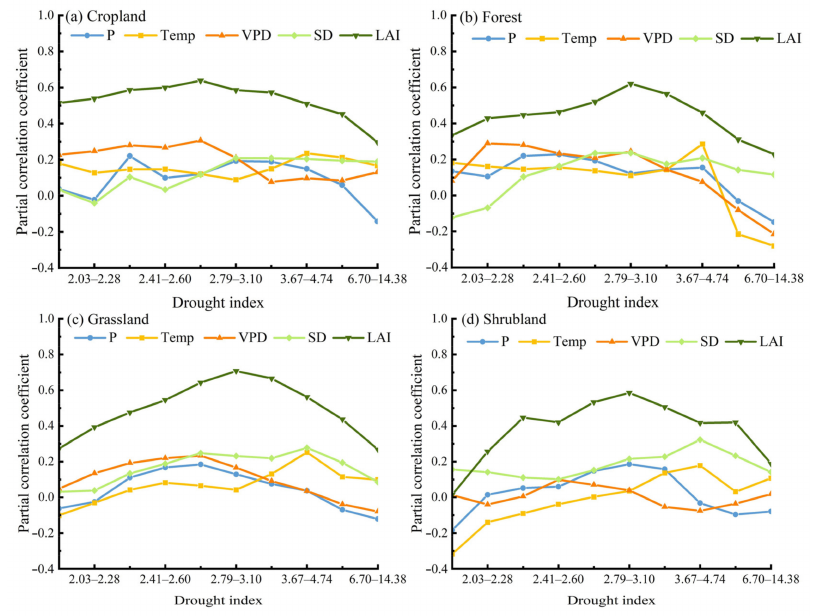
Figure 7. Variations in the coefficients between WUE and the different influencing factors with increasing drought index for the ( a ) cropland, ( b ) forest, ( c ) grassland, and ( d )